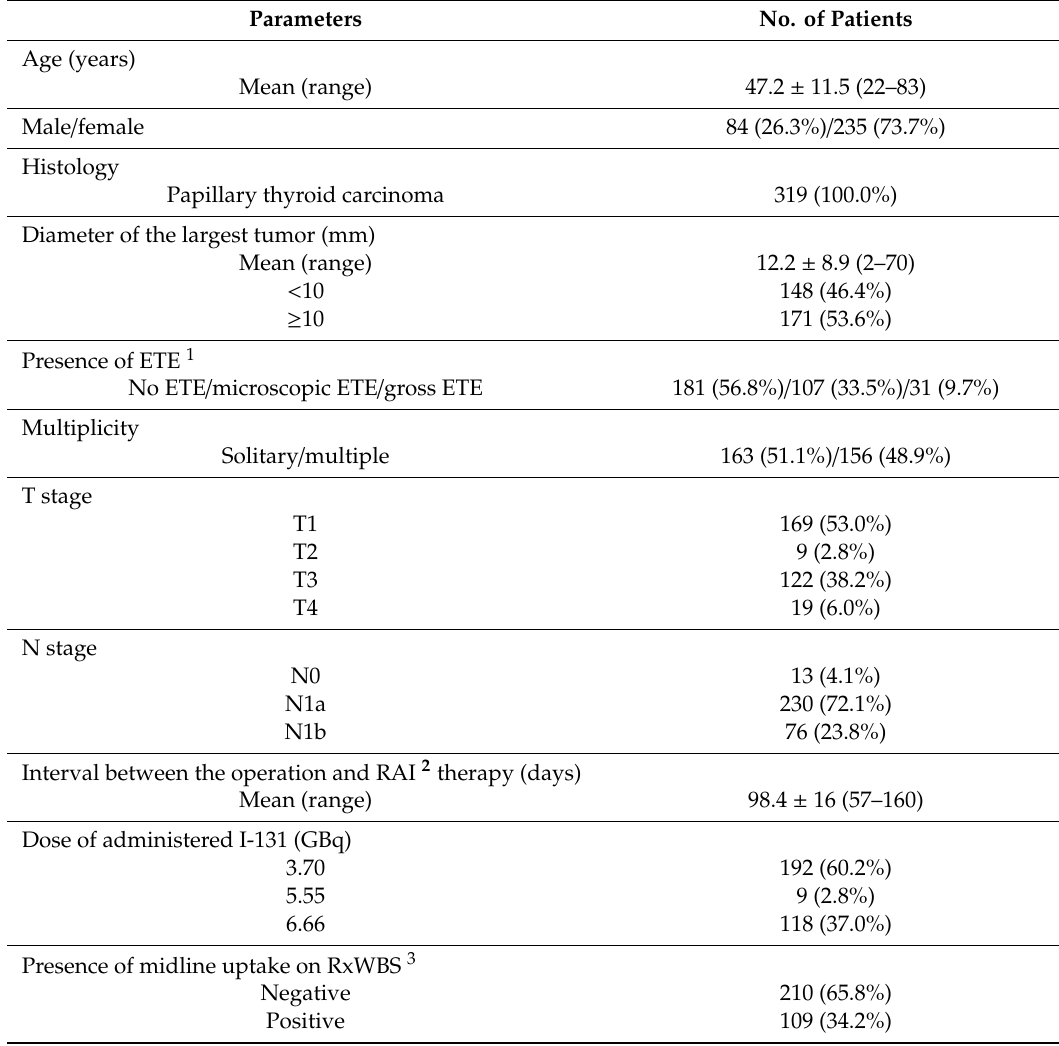
Table 1. Demographic distribution of the study population ( n =